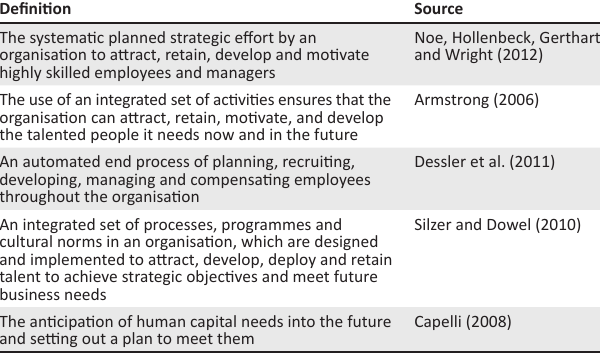
TABLE 1: Definitions of talent